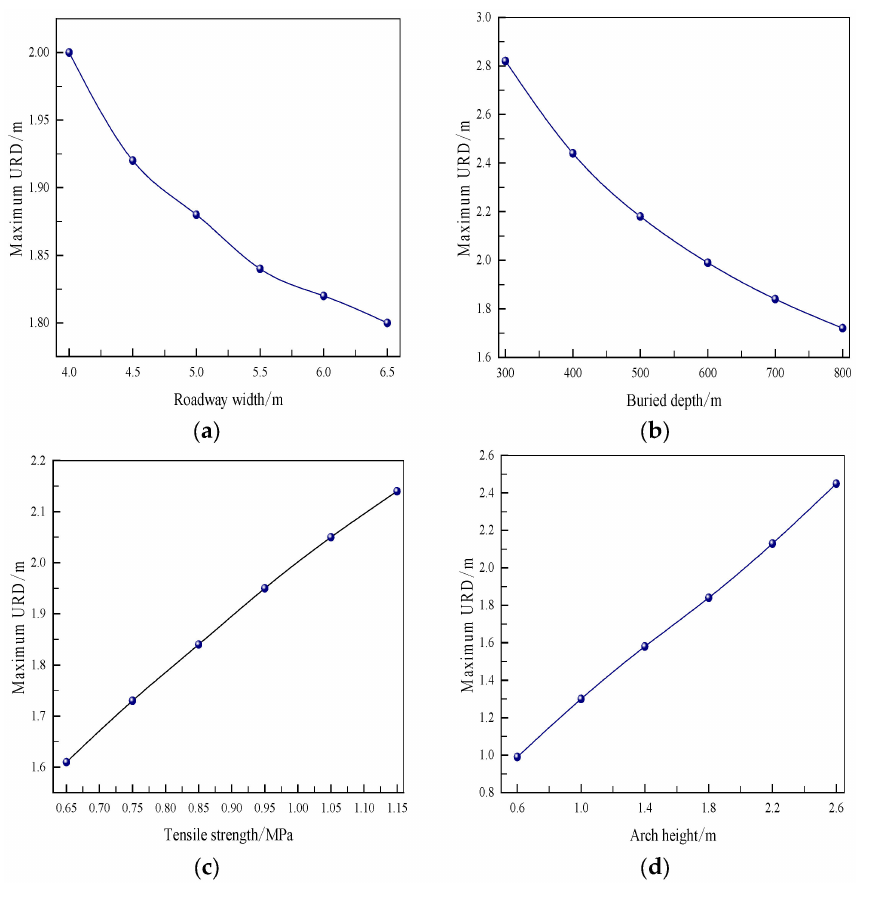
Figure 7. Roadway roof URDs under different influencing factors. ( a ) Roadway width vs. URD. ( b ) Buried depth vs. URD. ( c ) Tensile strength vs. URD. ( d ) Arch height vs.